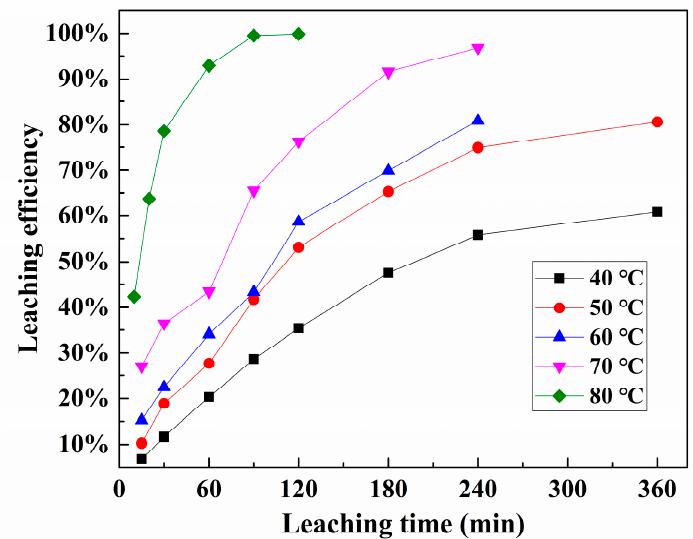
Figure 6. Leaching e ffi ciency of Pd from spent catalysts under di ff erent temperatures and times.